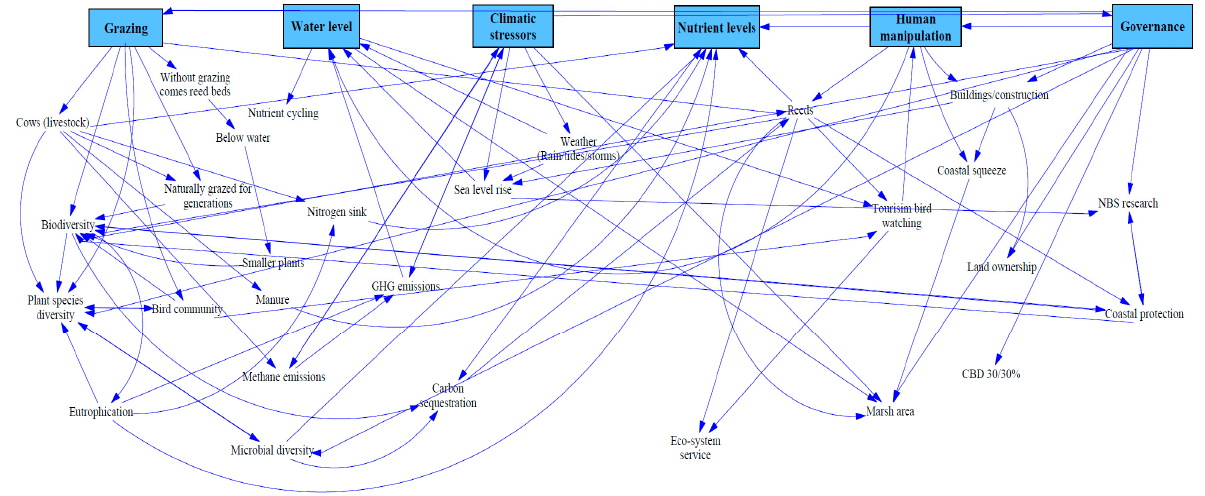
Figure 2. Vensim (vensim.com, accessed 3 March 2023) developed in the workshop. This is the representation of the systems-thinking part of the workshop, where the saltmarsh scientists discussed the effects of Nordic saltmarshes via the presented drivers (top blue boxes).